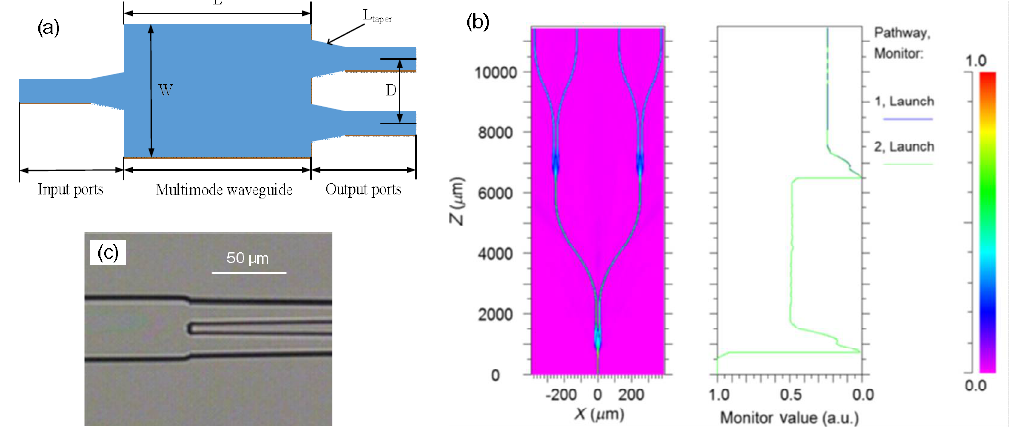
Figure 11. ( a ) Schematic of the MMI-based waveguide splitter; ( b ) the simulated beam propagation in 1 × 4 waveguide splitter; and ( c ) the microscopic image of the connection section between the multimode waveguide and the two single mode waveguides [52].